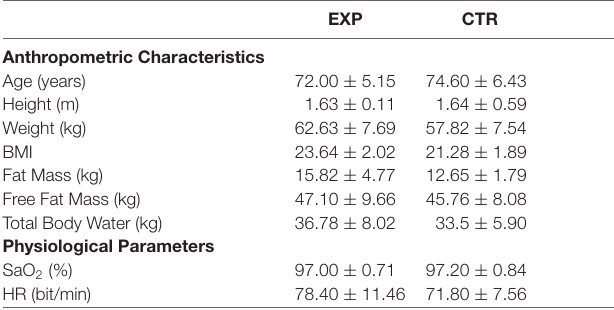
TABLE 1 | Baseline